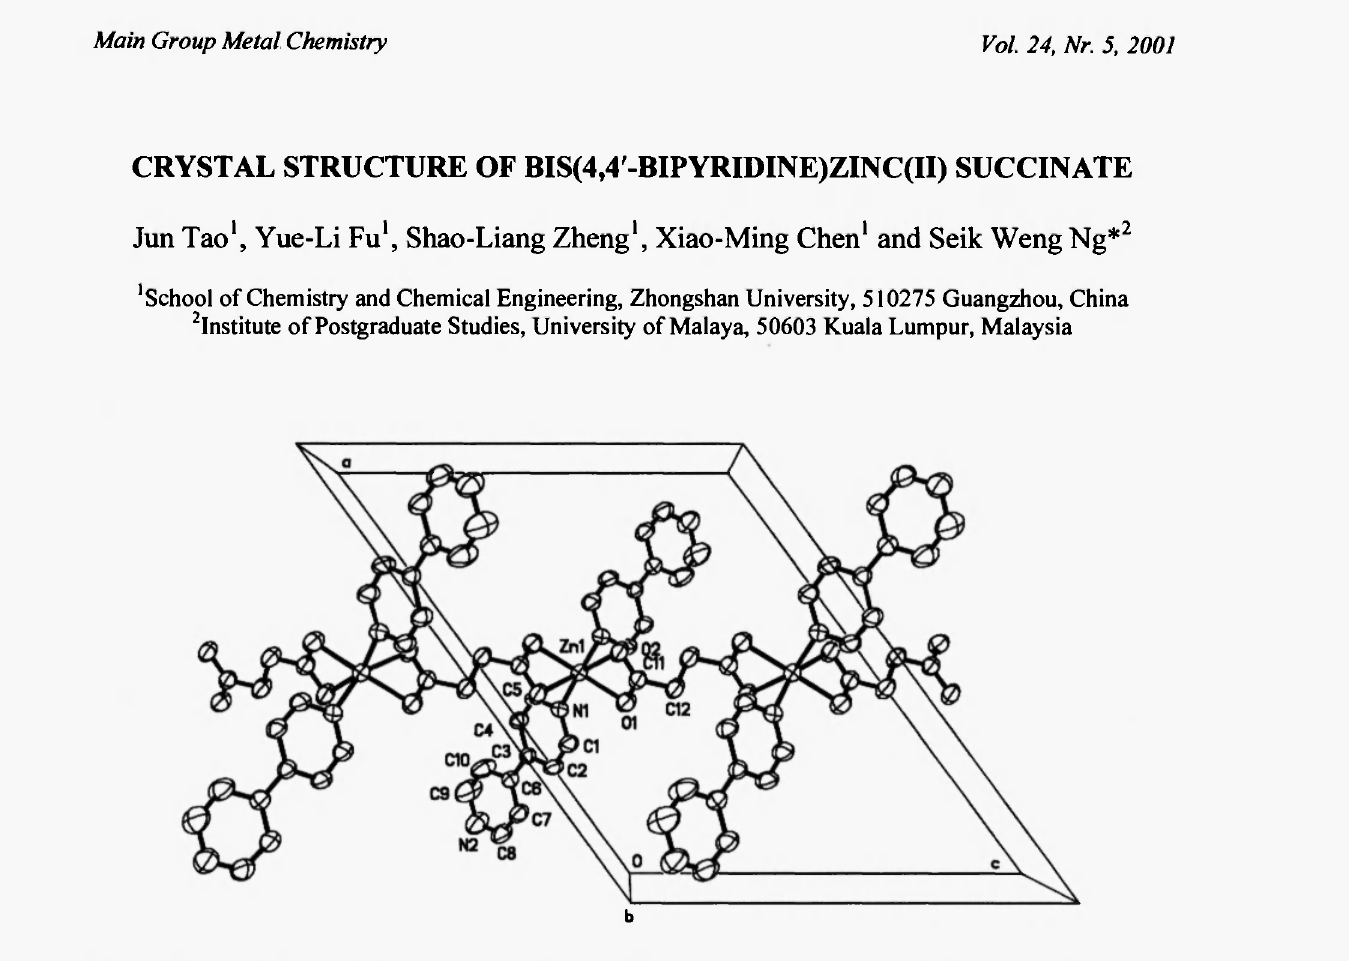
Figure 1. ORTEP plot of the title complex at the 50% probability level. Selected bond distances and angles: Znl-Ol = 2.064(2), Znl-02 = 2.317(2), Znl-Nl = 2.106(2) A; Ol-Zn-Ol' = 154.9(1), 01-Znl-02 = 59.7(1), 01-Znl-02" = 101.5(1), Ol-Znl-Nl = 96.4(1), Ol-Znl-Nl' = 100.3(1), Nl-Znl-N* = 96.4(1), Ν1-Znl-02 = 155.9(1), Nl-Znl-02 1 = 91.5(9), 02-Znl-02' = 90.5(1)°. Symmetry transformation: i = -x, y, 0.5-z.